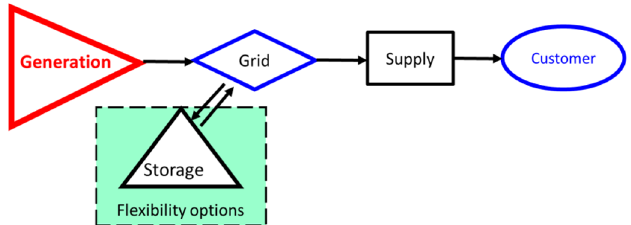
Fig. 1. The principle of conservative thinking in supplying customers